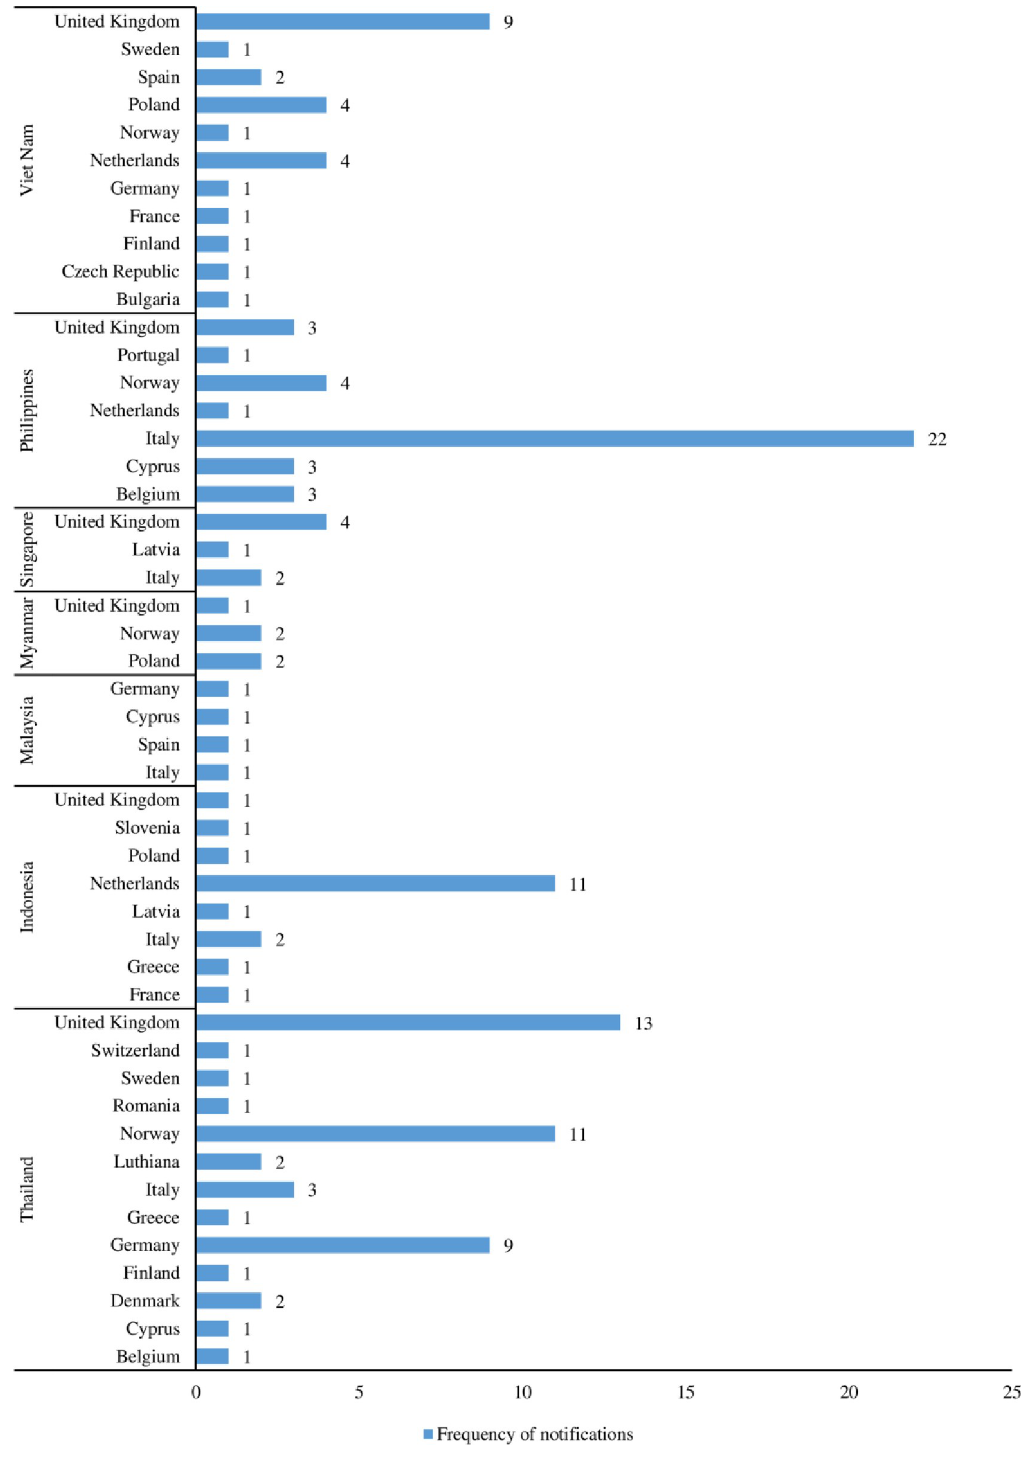
Fig 8. Frequency of notification s on food/feed exports from ASEA by importing countries (2000–2020).